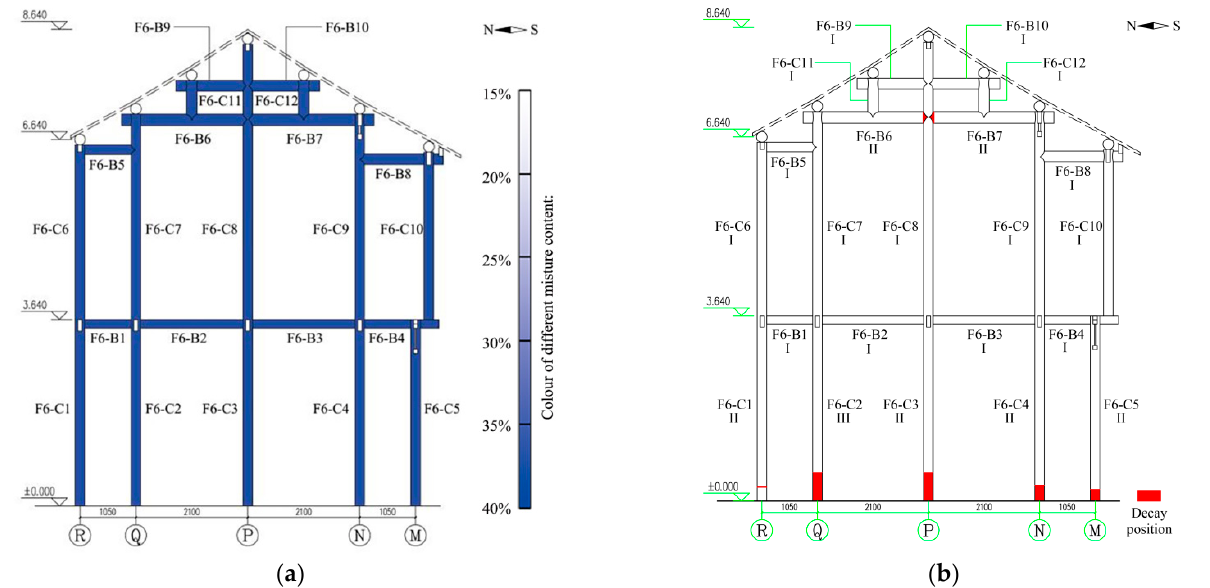
Figure 17. Moisture content and decay of F6 in Fujiu Zhou house; ( a ) schematic diagram of moisture content; ( b ) schematic diagram of decay position and decay grade.